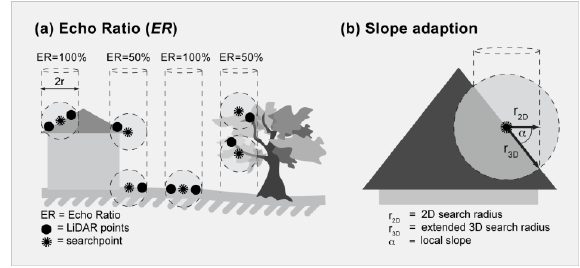
Figure 2: Definition of the Echo Ratio ER (Höfle et al., 2009).